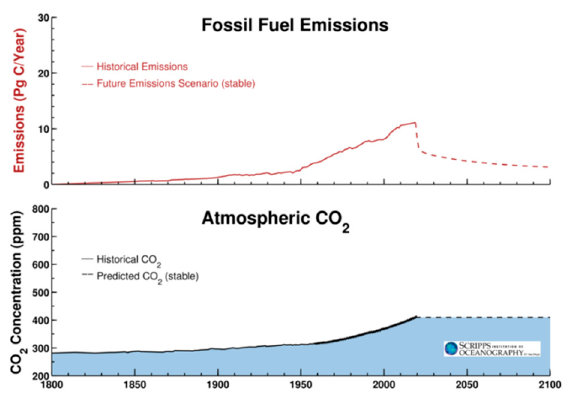
Figure 10. Emission trend for RCP6 scenario (Source: The Scripps Research Institute, Available from https://scripps.ucsd.edu/programs/keelingcurve/ ).